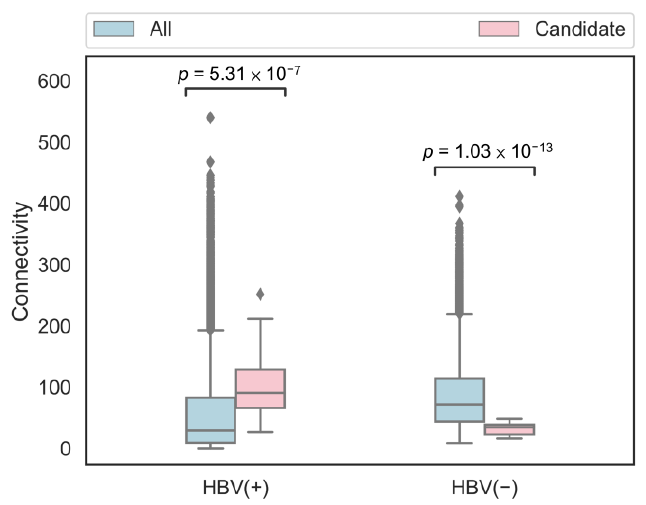
Figure 5. The boxplots of connectivity for all/candidate genes in the HBV(+) and HBV(−) weighted networks. p -value was obtained using the Mann–Whitney U